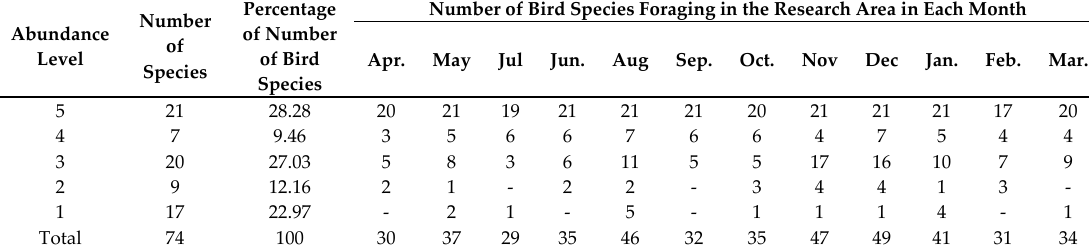
Table 1. Species diversity of birds sighted in 3 boat touring routes each month, categorized by abundance from April 2017–March